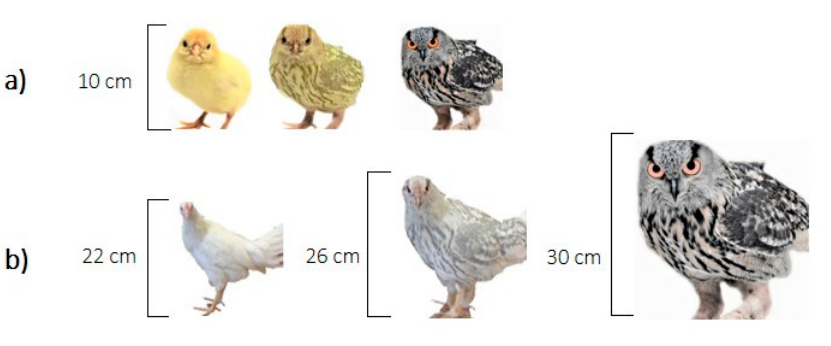
Figure 2. Stimuli used for measuring cognitive judgement bias at ( a ) 1, and ( b ) 10 weeks of age.